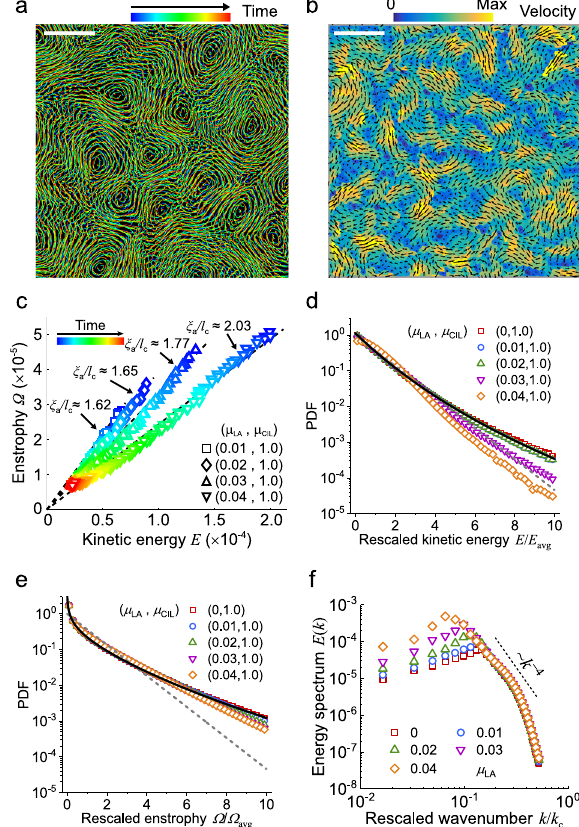
Fig. 5 Energetic statistics of mesoscale cell turbulence obtained from simulations. a Representative cell trajectories. The color code represents time. Scale bar, 10 cell length. b Representative velocity fi eld. Scale bar, 10 cell length. Parameter values: the self-propelled velocity v sp ¼ 0 : 1, the local ¼ 0 : 05, the contact inhibition of locomotion alignment (LA) intensity μ LA ¼ 1 : 0, the translational noise intensity ε ¼ 0 : 01, and (CIL) intensity μ T CIL the rotational noise intensity ε R ¼ 0 : 1. c The enstrophy Ω scales linearly with the kinetic energy E when the cell motility v sp decreases gradually over time. The dashed lines are linear fi ttings to as Ω ¼ E = ξ 2 . The characteristic a length scale ξ a showed in the plot is rescaled by the cell size l c . Parameter values: ε T ¼ 0 : 01 and ε R ¼ 0 : 1. d , e Probability density functions (PDFs) of d the rescaled kinetic energy and e the rescaled enstrophy regulated by cell – cell social interactions. Values are rescaled by their average. The gray dashed curves represent the Maxwell – Boltzmann distribution, while the black solid curves refer to the fi ttings to q -Gaussian distributions (Eq. (2) for d and Eq. (4) for e ) with the Tsallis index q ¼ 1 : 1. f Energy spectrum E ( k ) regulated by cell – cell social interactions. Here, we keep μ CIL fi xed, while only μ LA is changing. k c represents the wavenumber at the scale of one cell. The peak corresponds to typical vortex size. Parameter values: v sp ¼ 0 : 1, μ ¼ 1, ε ¼ 0 : 01, and ε ¼ 0 : T R CIL